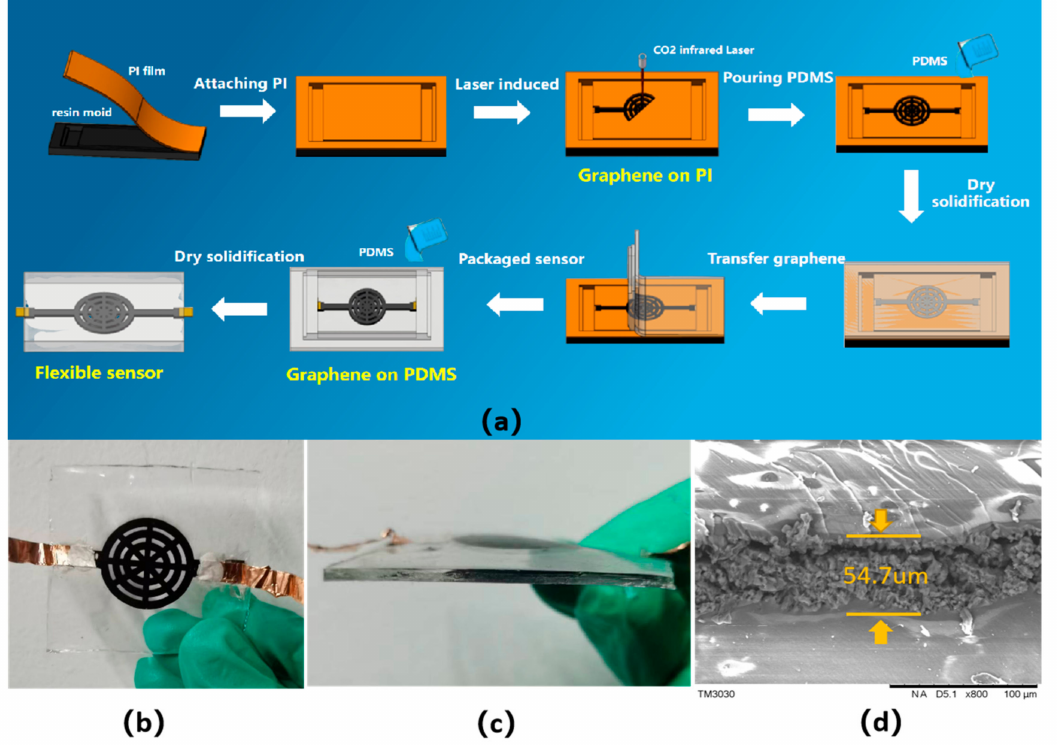
Figure 2. ( a ) Flow chart of the spider web structure flexible sensor fabrication; ( b ) Front view of the spider web structure flexible sensor; ( c ) Side view of the spider web structure flexible sensor; ( d ) Thickness of graphene transferred on the the spider web structure flexible